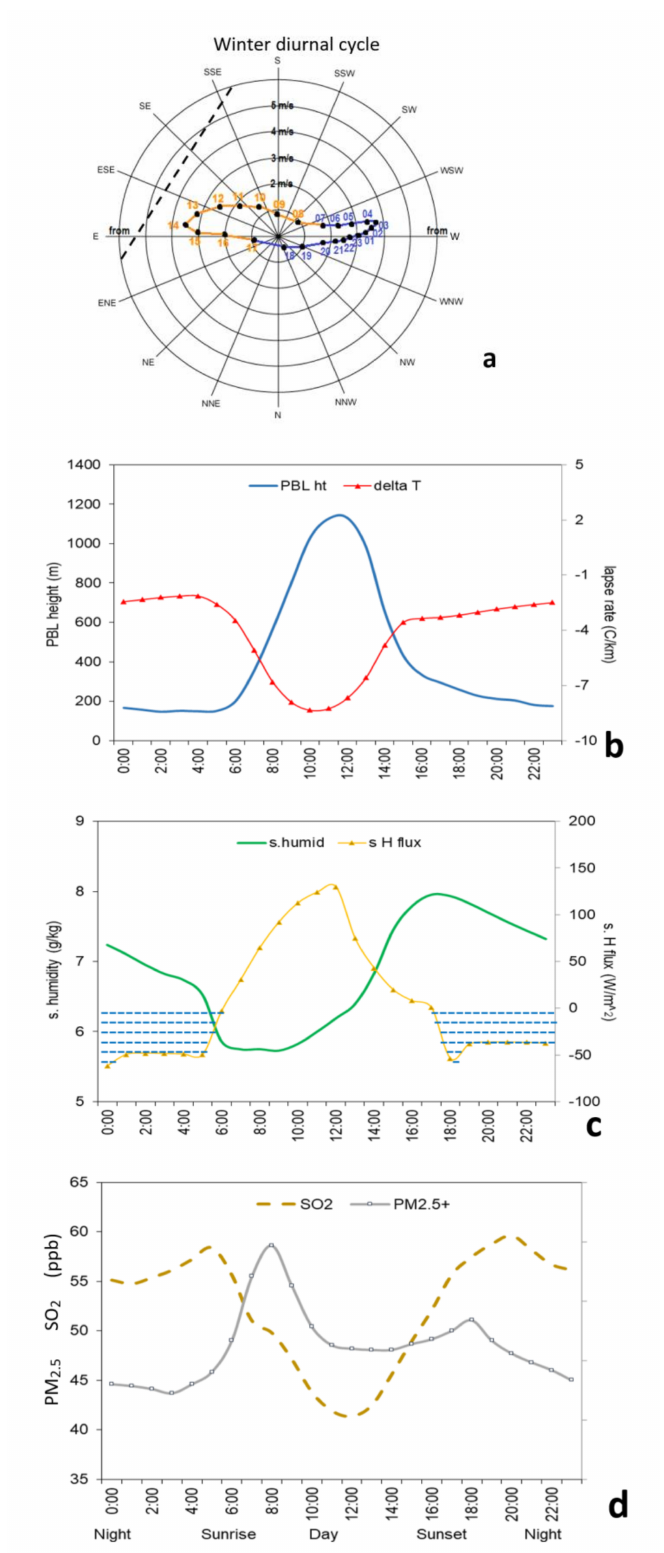
Figure 6. Winter mean diurnal cycle of over the Durban-area (2011–2015): ( a ) hodograph of MERRA2 near-surface wind velocity, all times UTC (local +2) with day-night shading, ( b ) PBL height and delta temperature, ( c ) specific humidity and sensible heat flux (nocturnal cooling <0 dashed), ( d ) DAQM in situ air constituents. Dashed line in ( a ) is the coastal